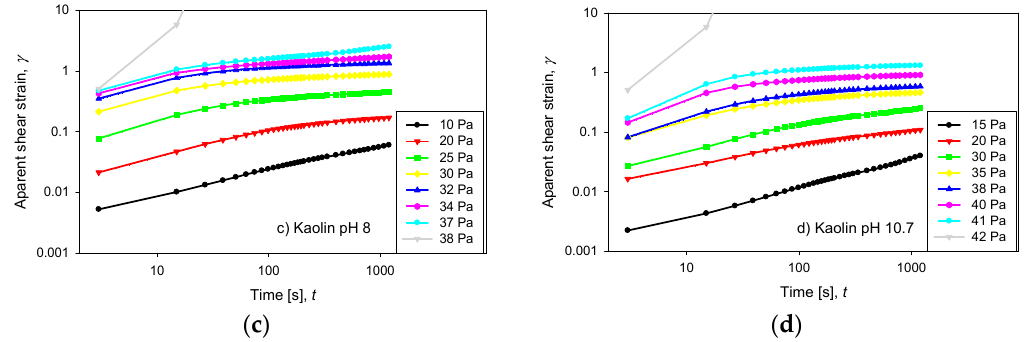
Figure 6. Creep test for quartz and kaolin slurries at varied applied stresses: ( a ) quartz at pH 8, ( b ) quartz at pH 10.7, ( c ) kaolin at pH 8 and ( d ) kaolin at pH 10.7.